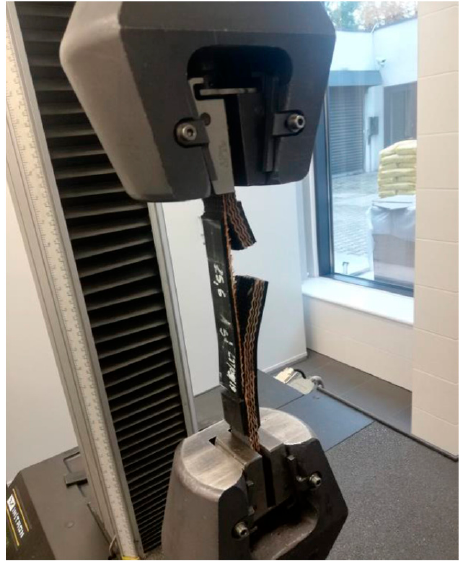
Figure 9. Schematic view of the specimen prepared for splice shear strength tests.